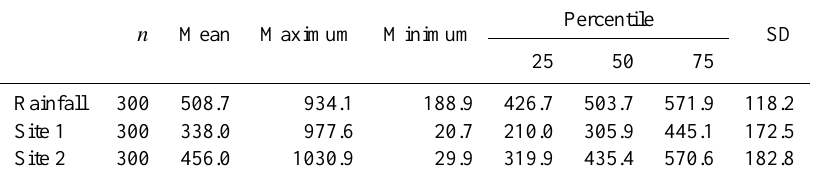
300 years. B) for ten years at the daily timescale (the green shade represents +/- 1 standard deviation of